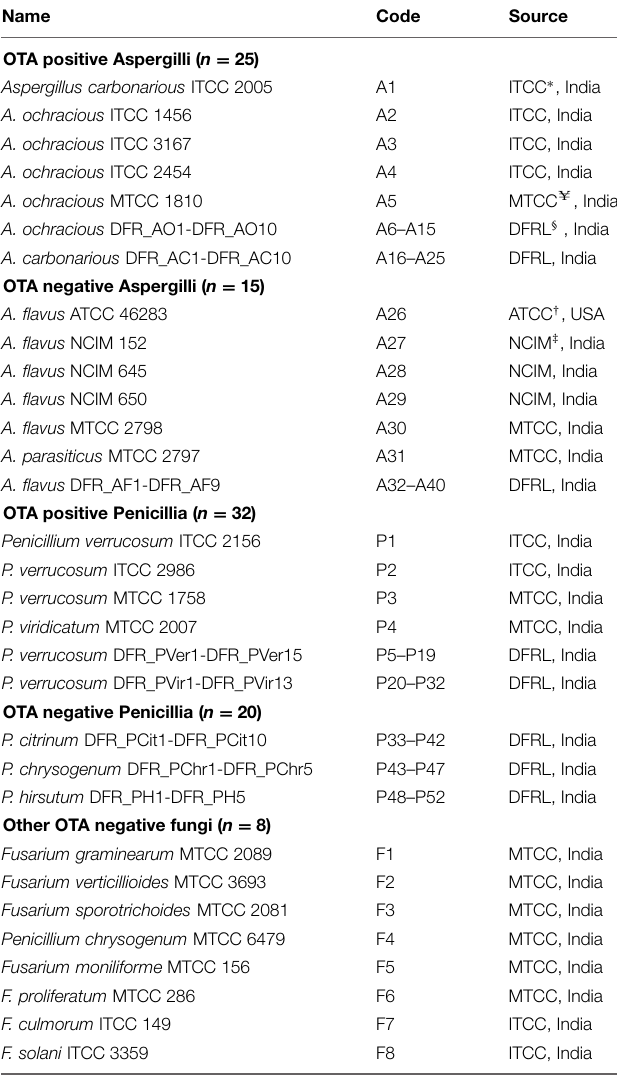
TABLE 1 | Standard cultures and fungal isolates used in present